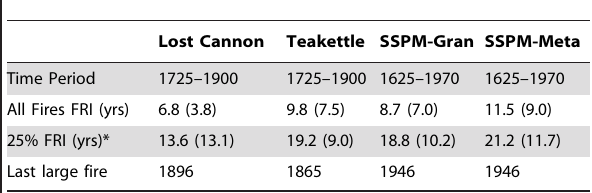
Table 2. Mean (one standard deviation) fire return interval (FRI) summaries for old-growth Jeffrey pine-mixed-conifer forests in the Sierra Nevada, California, and northwestern